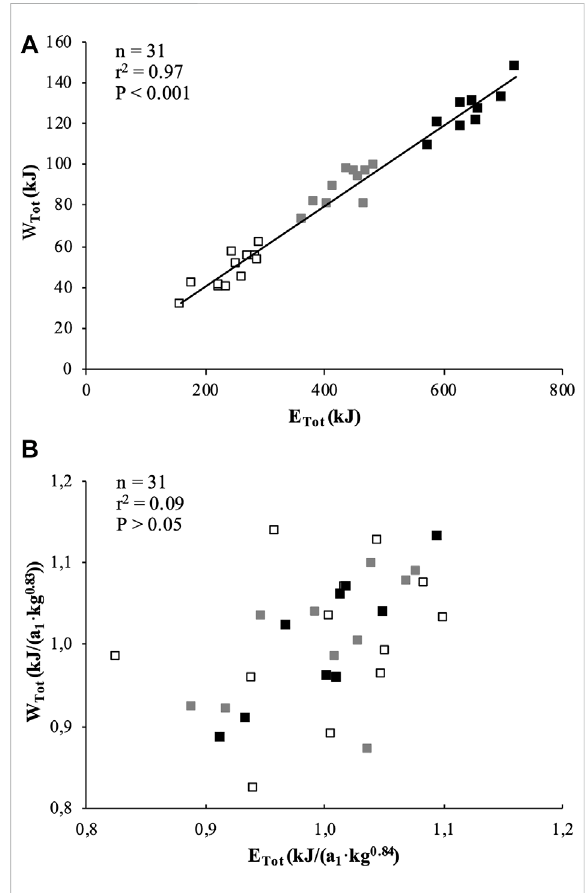
FIGURE 2 Correlations between total mechanical work (W Tot ) and total energy released (E Tot ) during the exhaustive rowing ergometer exercise expressed in absolute values (A) and allometrically scaled for body mass (B) . Black squares represent U18, grey squares represent U16 and white squares represent U14